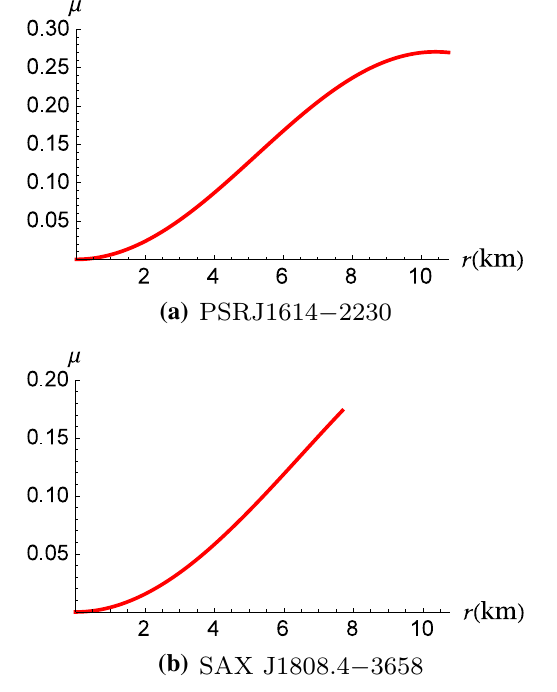
Fig. 7 Variation of compactness factor verses the radius